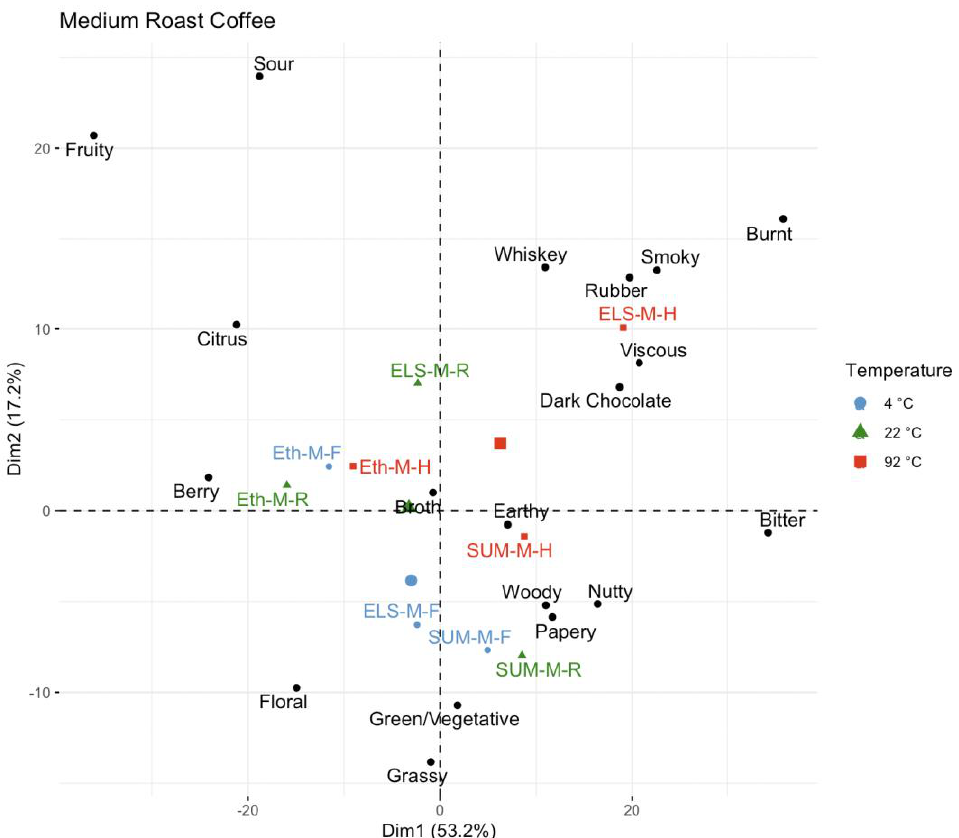
Figure 8. A principal component analysis of medium roast coffees, color-coded by brew tempera- ture.